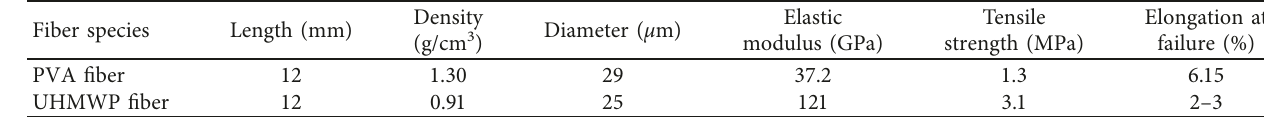
Table 1: Fiber physical parameters.